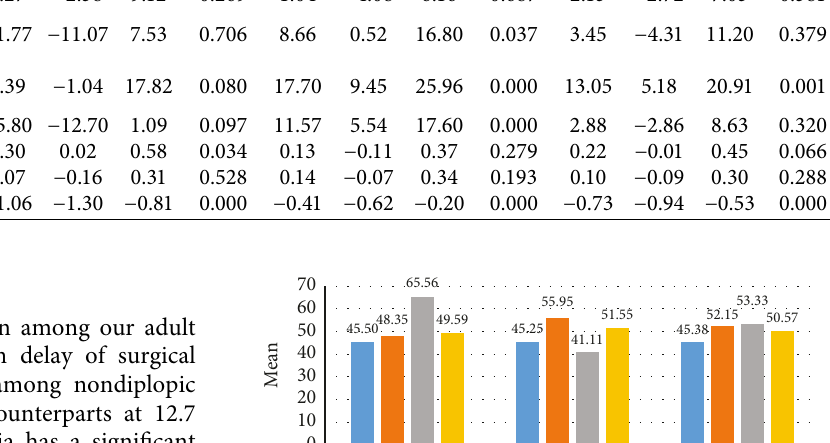
Gender (female vs. male)